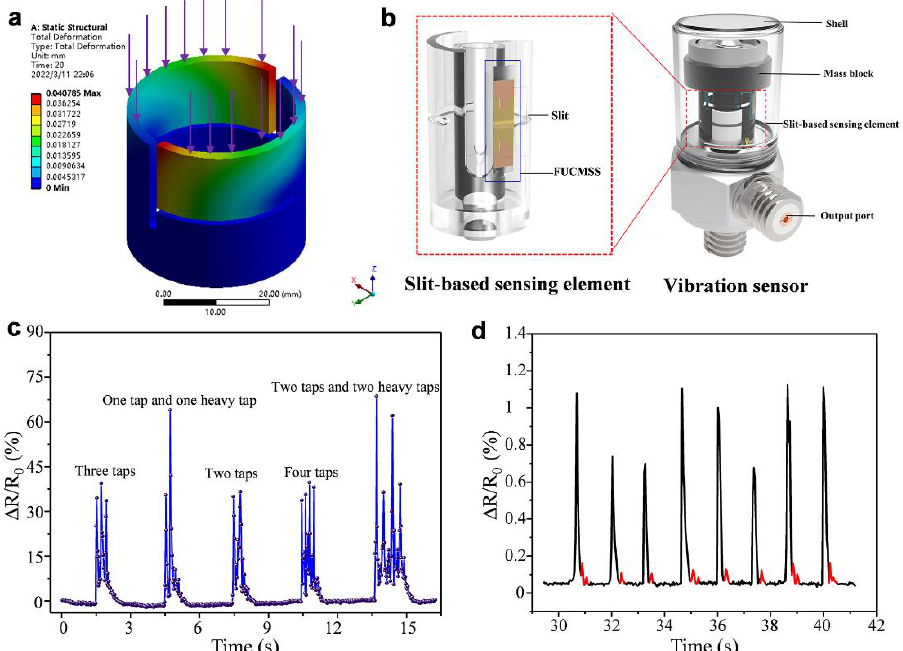
Figure 11. The vibration sensor based on the bio-inspired strategy. ( a ) The deformation of slit wake in the case of a slit processed on a hollow cylinder. ( b ) the composition of slit-based vibration sensor. ( c ) The resistance response of vibration sensor to desktop knocking signal. ( d ) Detection of mechanical signal generated by the impact between the steel ball and the desktop.